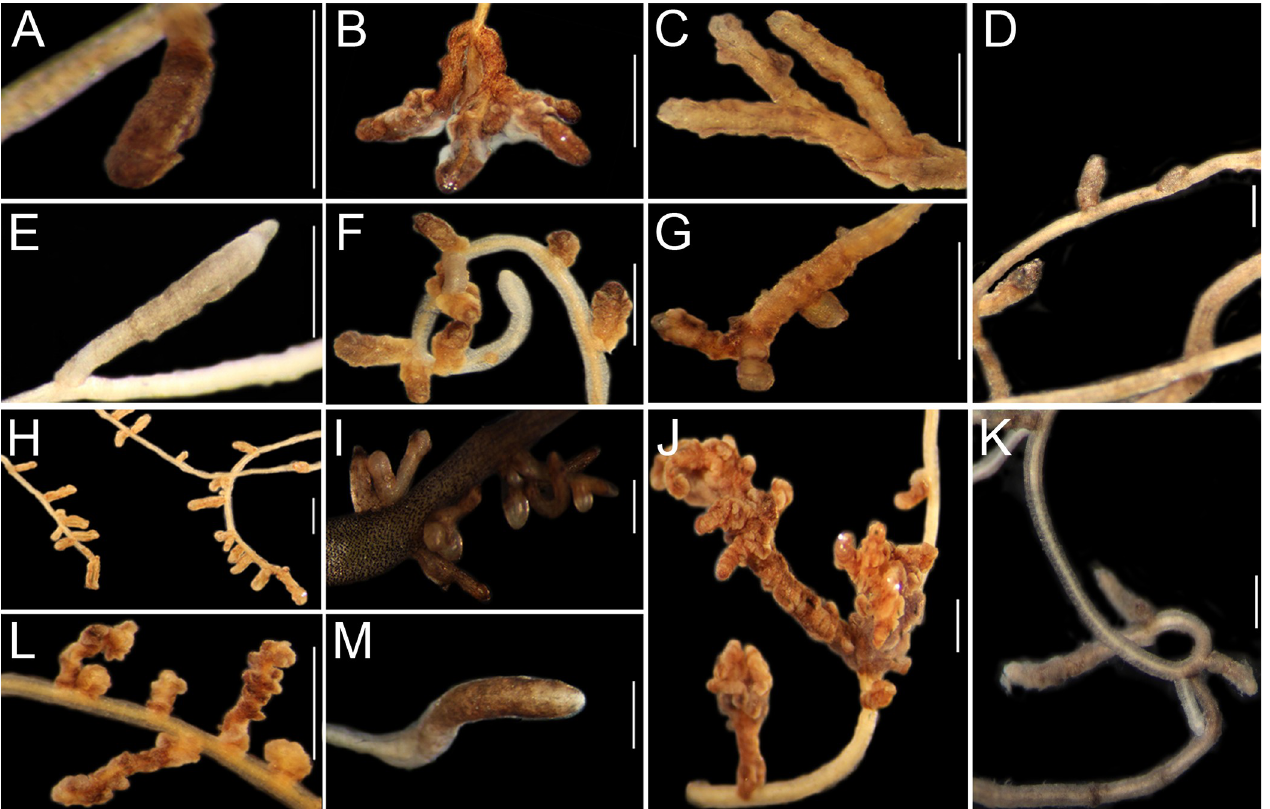
Fig 2. Ectomycorrhizal root tips of: T . portentosum with C . psilosepalus ( A ), C . ladanifer ( B ), H . halimifolium ( C ) and T . lignosa ( E ); T . equestre with C . ladanifer ( F ) and H . halimifolium ( G ); L . deliciosus with C . ladanifer ( H ), C . salviifolius ( I ), C . psilosepalus ( J ), H . halimifolium ( L ) and T . lignosa ( M ); and B . fragrans with C . psilosepalus ( D ) and C . salviifolius ( K ). (Bar = 1mm).